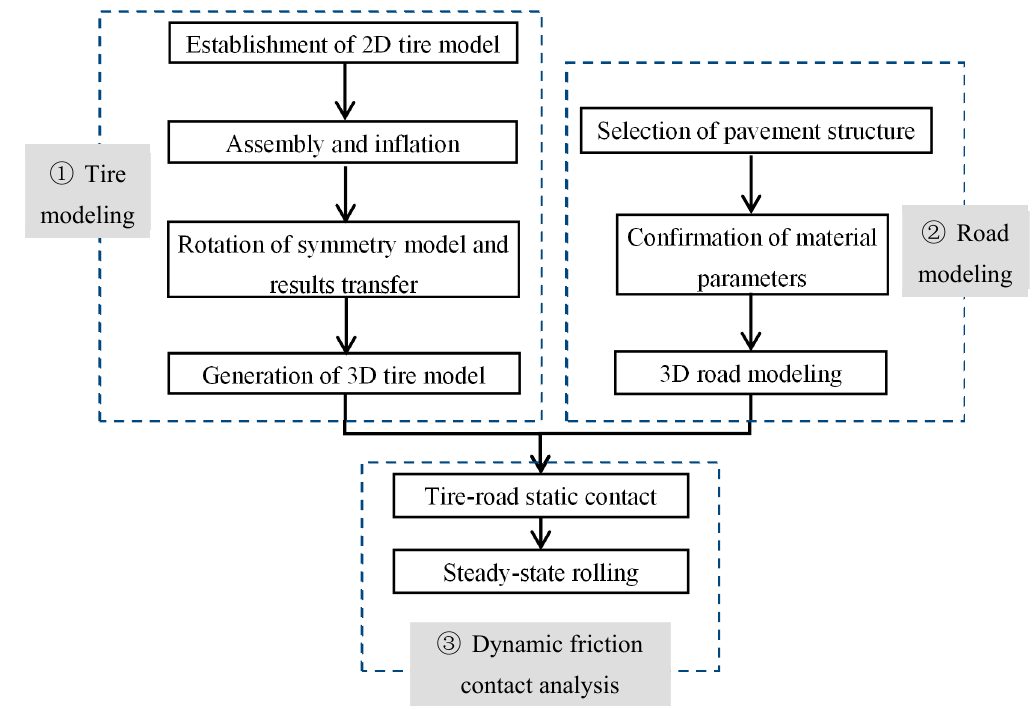
Figure 2. 3D Tire-road contact modeling steps in ABAQUS.